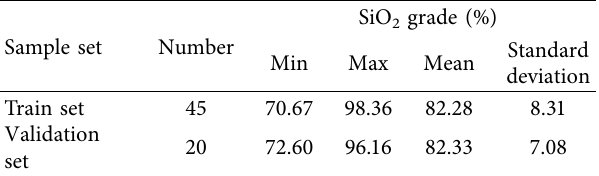
Table 3: Descriptive statistics of sample set. Table 4: Assessment of the PLSR prediction